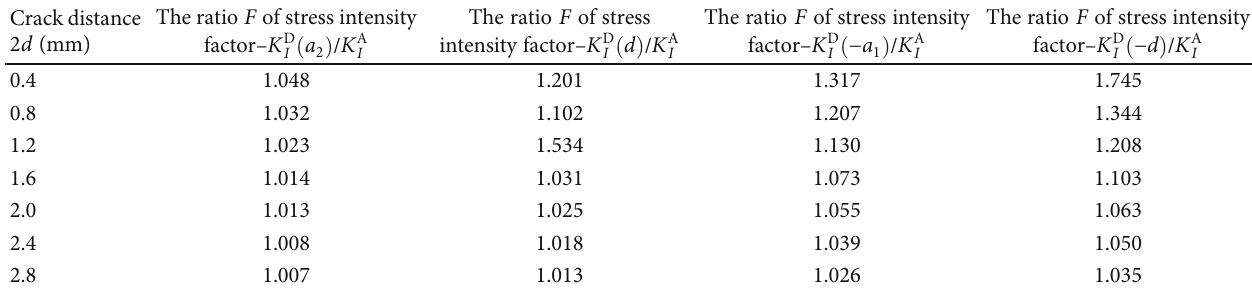
Table 2: Relationship between the ratio F of stress intensity factor and the length of the main crack ( l The length of main crack l 1